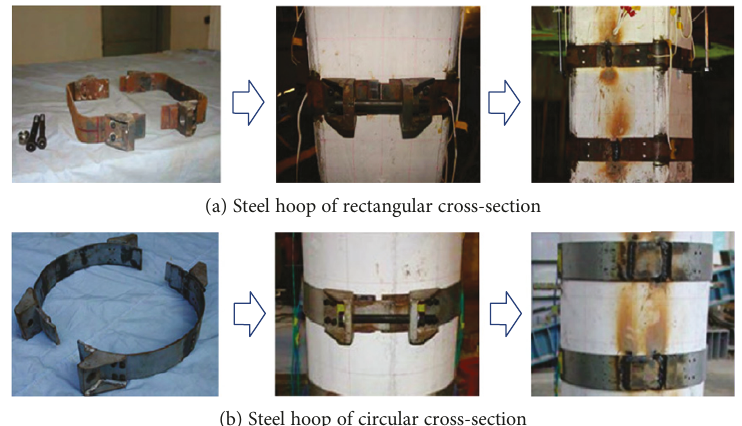
Figure 2: The reinforcement method of improved prestressed steel